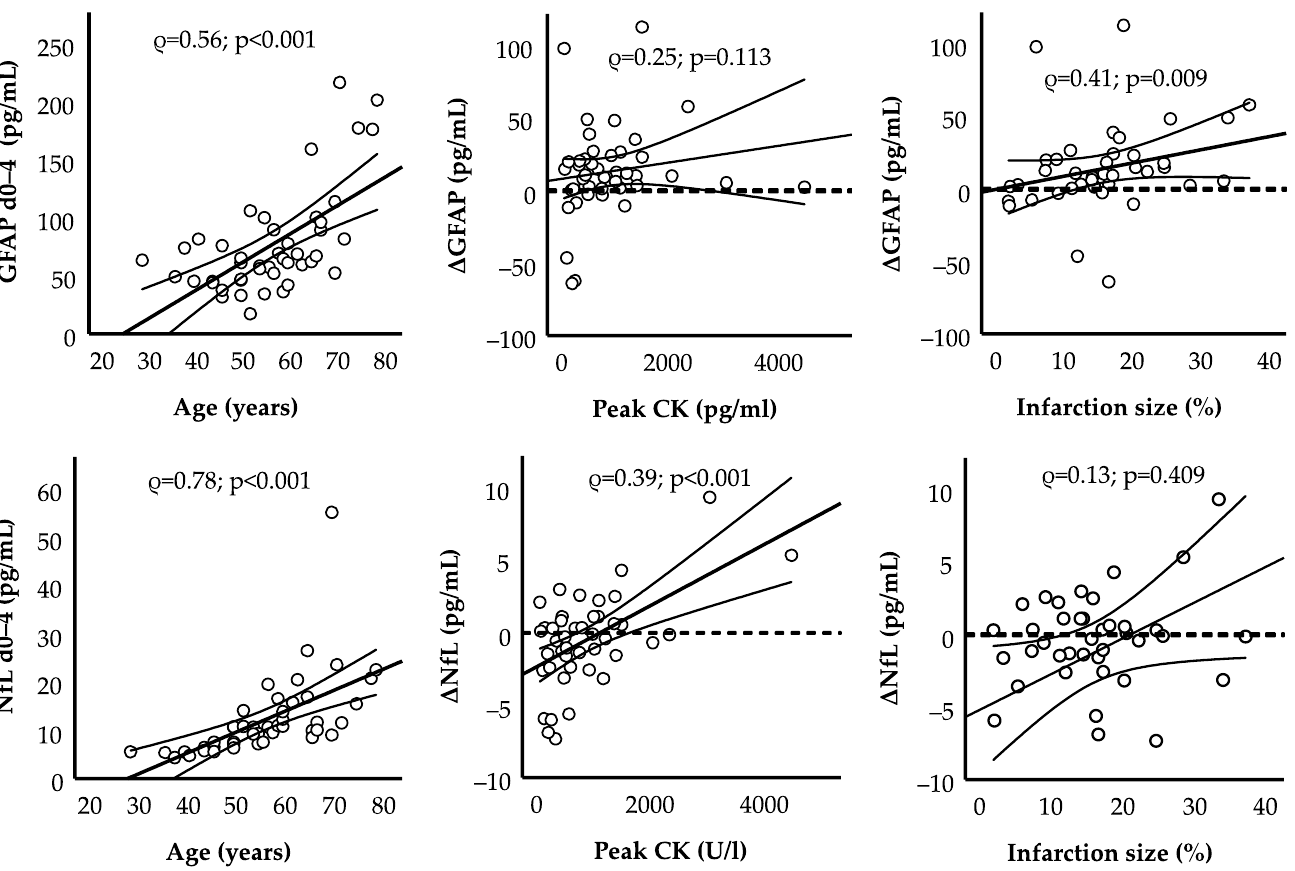
Figure 2. Spearman’s correlation of serum biomarkers and change over 12 months ( ∆ ). Dots represent single patients ( n = 45). CK = creatine kinase; ρ = Spearman’s rho. Solid trend lines and standard deviation (thin lines) are shown. Table 3. Course of laboratory parameters after first STEMI and correlation to ΔGFAP. * = significant change in Wilcoxon matched-pairs signed-ranks test.